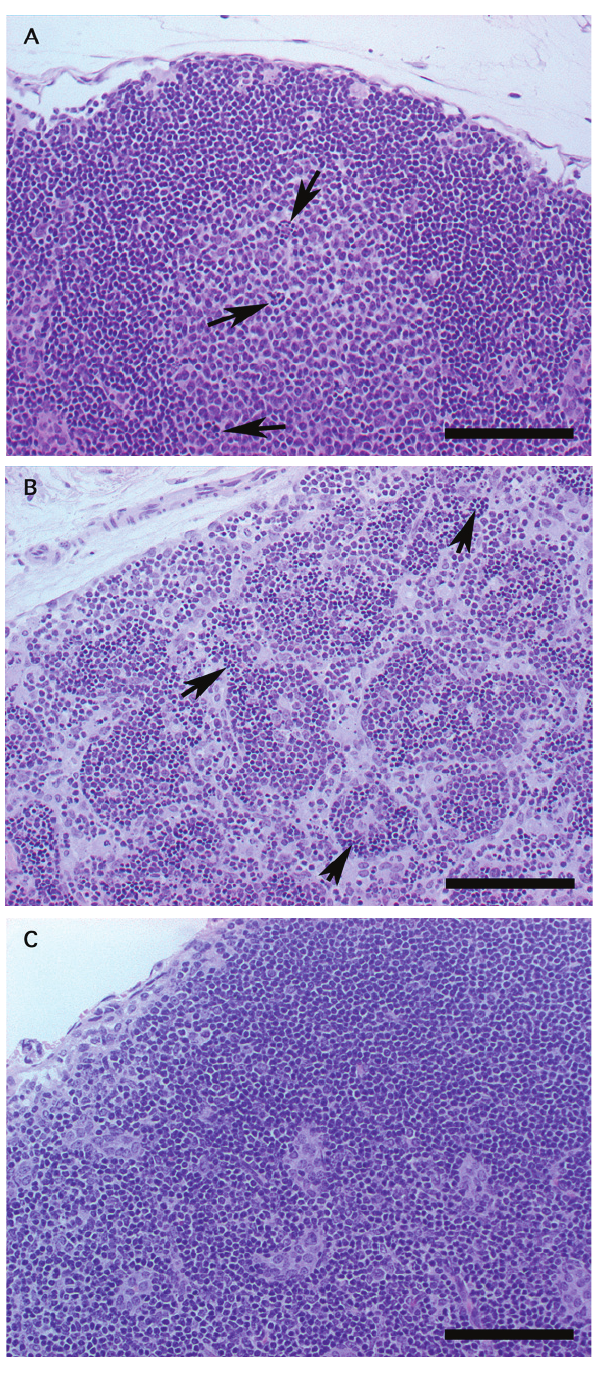
Figure 1. Sections of lymph nodes in mice ip treated with pure ricin were stained with hematoxylin and eosin. A. Lymph node at day one post-intoxication. Several tingible body macrophages (arrows) are present within a follicle consistent with lymphoid reactivity. B. Lymph node at day two post-intoxication. There is moderate lymphoid necrosis characterized by clusters of small, dark basophilic, round apoptotic bodies (arrows) admixed with intact lymphocytes. C. Lymph node from non-treated control mouse for comparison. Bar=100 m m.